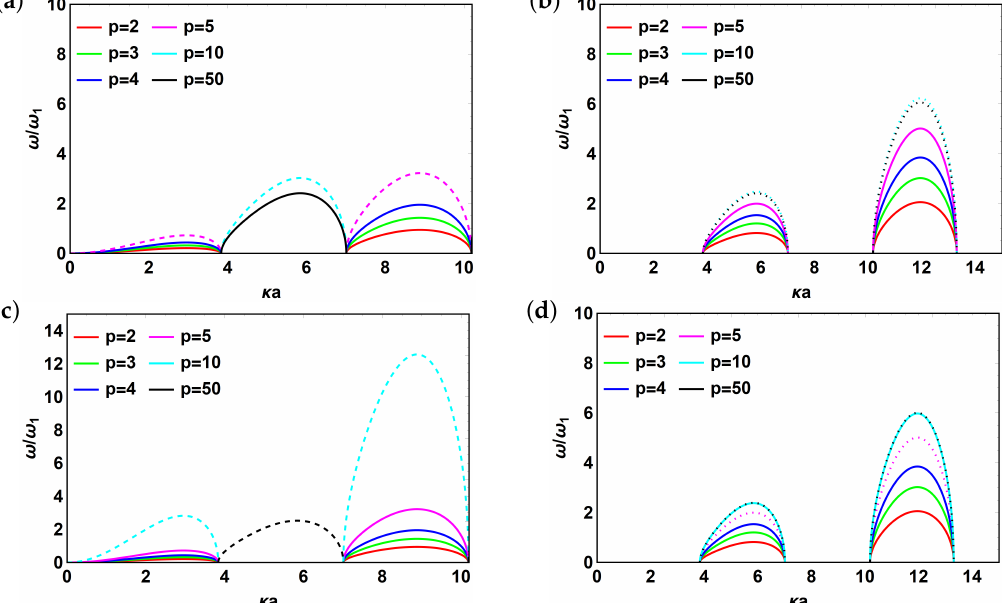
Figure 3. Dispersion relation for metascreen ( a ) w/1 interface and w/reflector ( r 0 = 0.5), k h (cid:28) 1, δ (cid:28) 1, “negative” branch; ( b ) w/1 interface and w/reflector ( r 0 = 0.5), kh (cid:28) 1, δ (cid:28) 1, “positive” branch; ( c ) w/1 interface and w/reflector ( r 0 = 0.5), kh (cid:28) 1, “negative” branch; ( d ) w/1 interface and w/reflector ( r 0 = 0.5), kh (cid:28) 1, “positive” branch. For all plots n = 1, q = 2. Dashed lines in ( a , c ) are used to demonstrate switching between modes; dotted lines in ( b , d ) demonstrate the largest resonant peak for various configurations of metamaterial and compare it with the case of independent scatterers (black